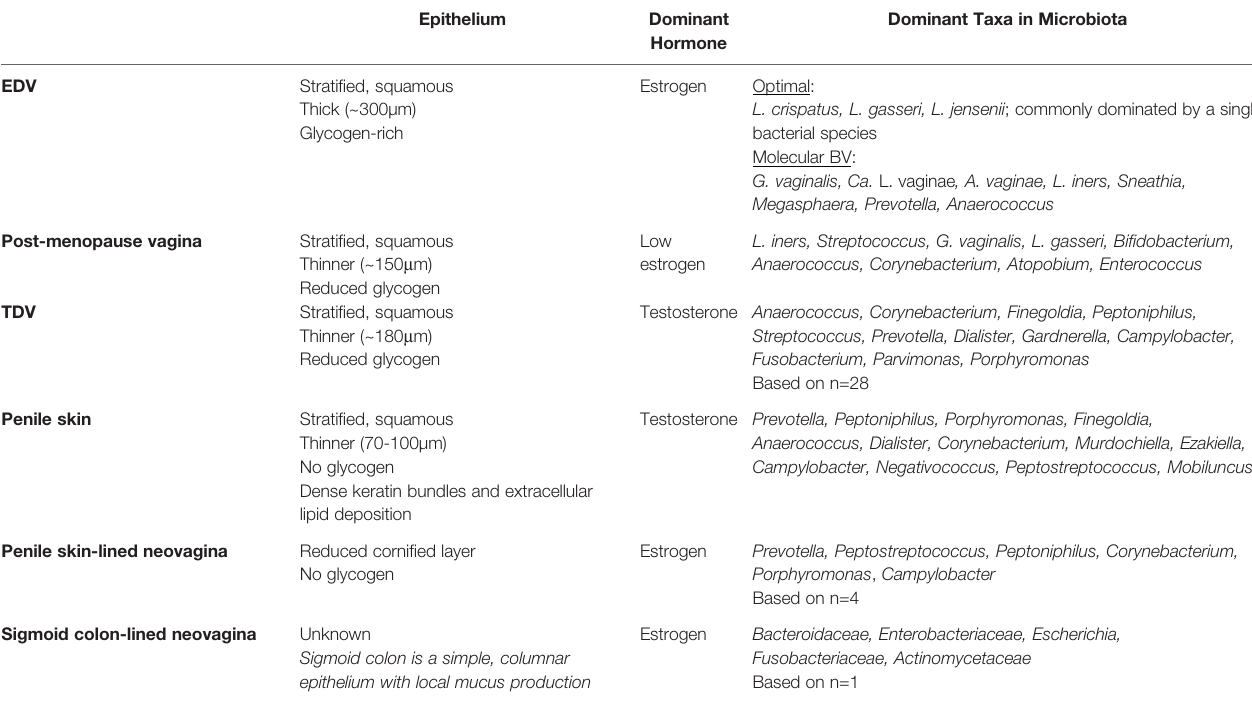
TABLE 3 | Summary of the characteristics of the estrogen dominated vagina (EDV), post-menopause vagina, testosterone dominated vagina (TDV), sub-preputial penile skin, penile skin-lined neovagina, and sigmoid-lined